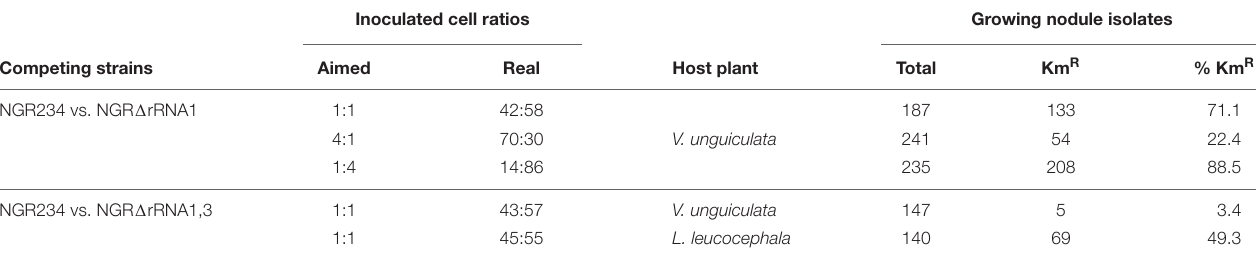
FIGURE 3 | Kinetics of nodulation for NGR234 and rRNA-deletion mutants. Plants of V. unguiculata were harvested at 12, 24, and 36 days post-inoculation (dpi). For each time point, the nodule number (A) , nodule fresh weight (B) , and shoot dry weight (C) was averaged for 10–12 plants inoculated with either NGR234 (O), NGR (cid:49) rRNA1 ( (cid:49) ), NGR (cid:49) rRNA3 ( (cid:3) ), and NGR (cid:49) rRNA1,3 ( ) strains. For non-inoculated control plants (X) that did not carry nodules, only the SDW and SPAD values are shown. Relative chlorophyll contents that are expressed as mean SPAD values for eight plants per treatment (D) , were measured every 3 days, starting at 12 dpi. (cid:32) Standard deviations are shown as bars above and below each data point. TABLE 2 | Competition of NGR234 and rRNA-deletion mutants for nodulation of V. unguiculata and L. leucocephala . Inoculated cell ratios Growing nodule